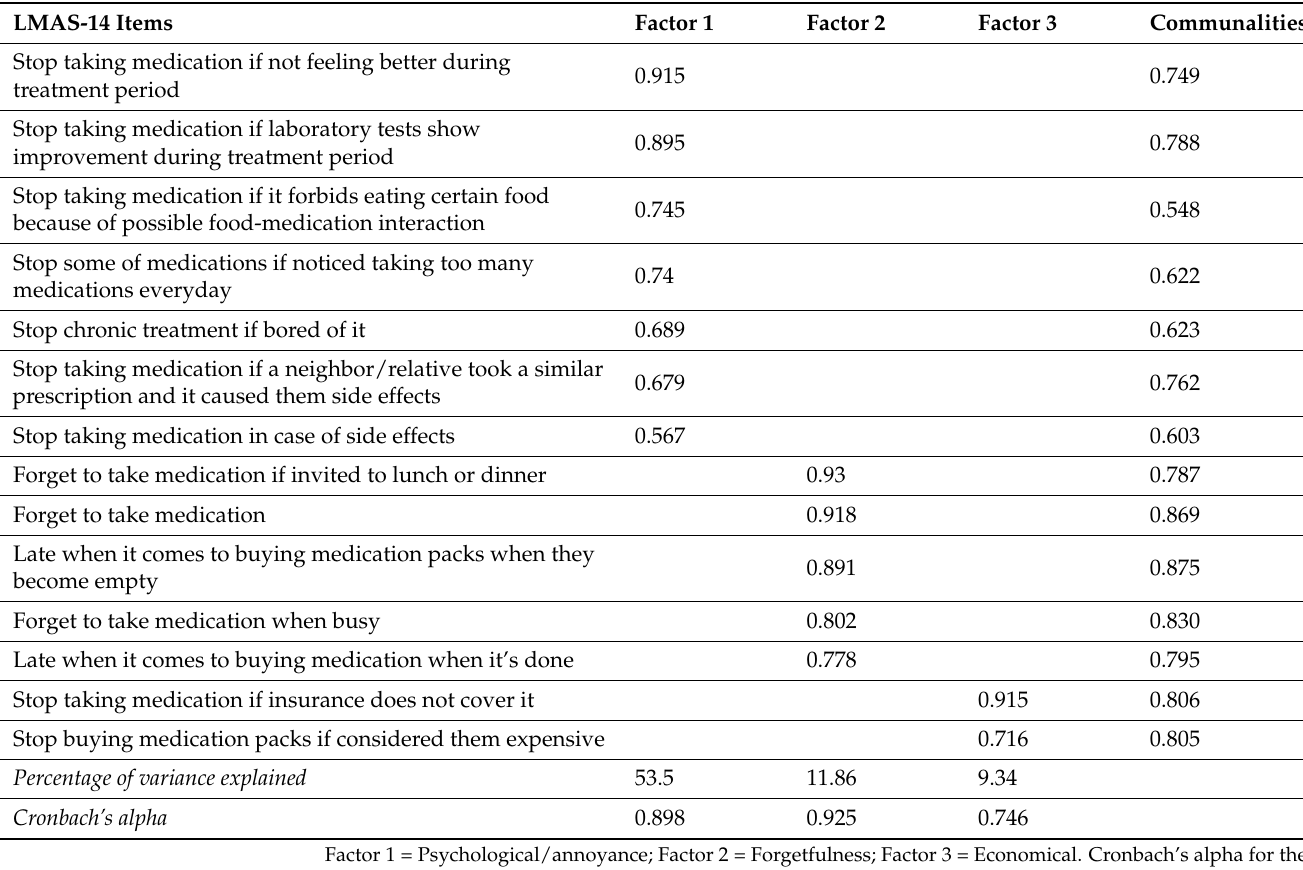
Table 3. Promax rotated matrix of the LMAS-14 among stroke survivors.